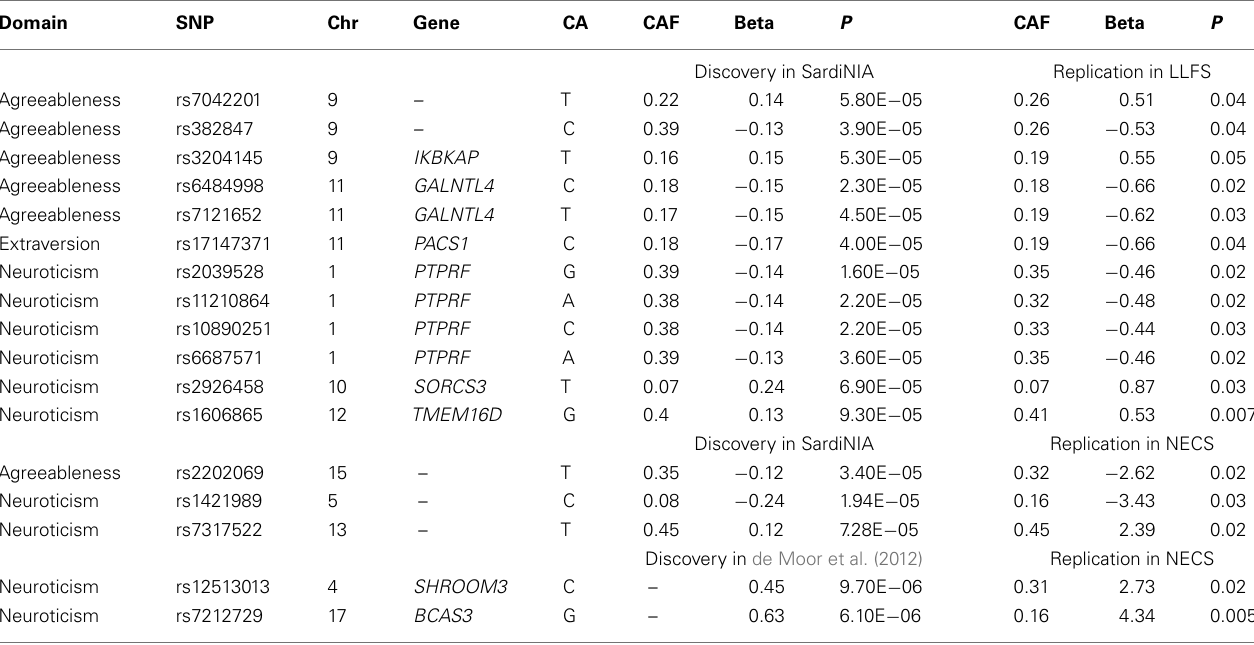
Table 3 | Summary of SNPs from previous GWAS that replicated in the LLFS and the NECS.